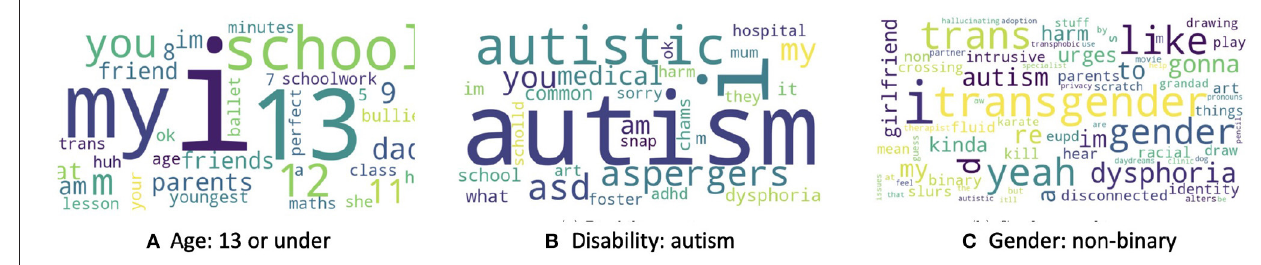
FIGURE 5 | Word cloud for words that best explains the model predictions for (A) age group 13 or under, (B) autism, and (C) non-binary gender.